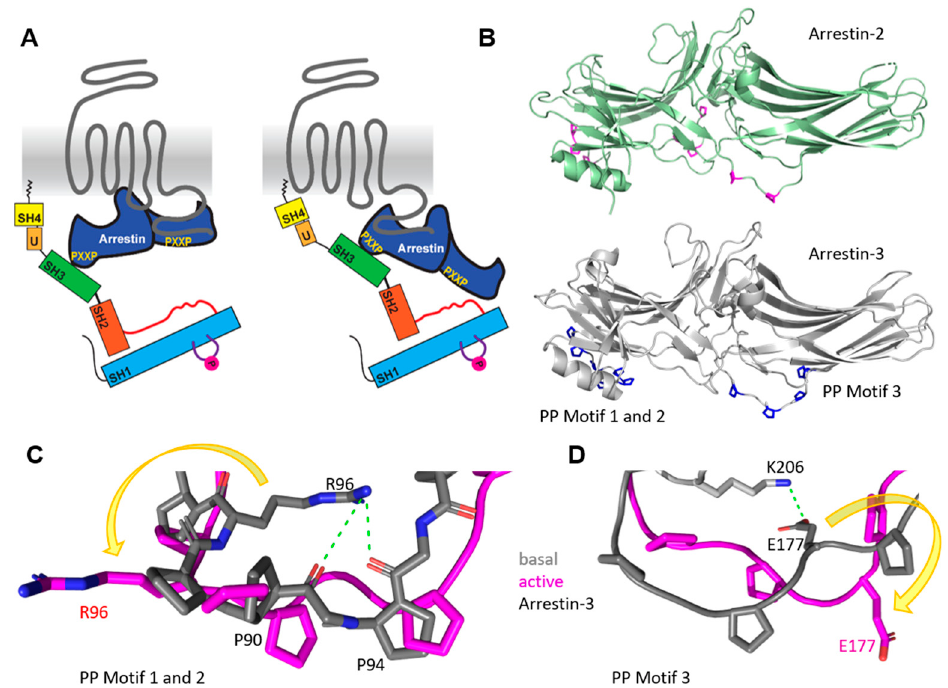
Figure 2. Binding motifs in arrestin-3 but not in arrestin-2 show structural rearrangement with activation. ( A ) Cartoon of arrestin-mediated SFK activation in the ‘core’ ( left ) and the ‘tail’ conformation ( right ) of arrestin. The activating receptor is shown in grey, arrestin is colored in dark blue with yellow polyproline motifs, and SFK color scheme was described earlier. ( B ) Structure of basal arrestin-2 in green with polyproline motifs in magenta (PDB file 1JSY [77]) and arrestin-3 with highlighted polyproline motifs in blue that are surface-accessible in a receptor-bound state (PDB file 3P2D [78]). ( C ) The comparison of polyproline motifs 1 and 2 in the basal (grey) and active (magenta) arrestin-3 conformations shows a large structural rearrangement with a 180 ◦ rotation of the R96 (indicated by a yellow arrow). In the basal state of arrestin-3, R96 forms electrostatic interactions with the backbone of the polyproline motif 1. ( D ) The comparison of polyproline motif 3 between basal (grey) and active (magenta) states shows an 180 ◦ outward movement of E177 in the active state (indicated by yellow arrow). For comparison of basal and active arrestin-3, PDB files 3P2D and 5TV1 were used [71,78].